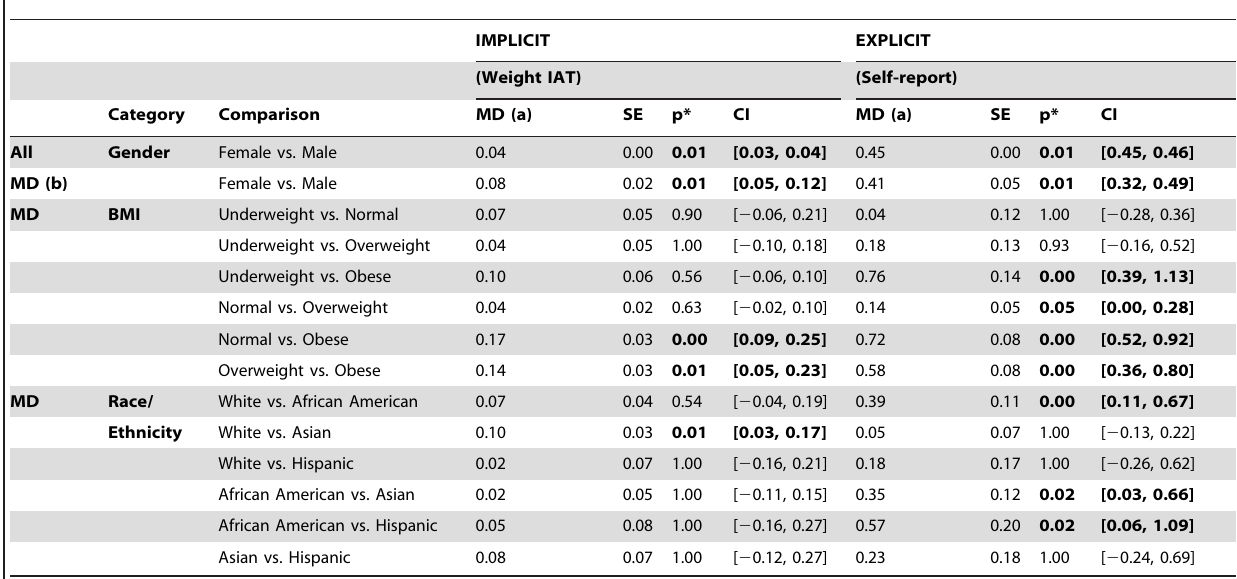
Table 3. Pairwise Comparisons of Implicit and Explicit Weight Attitudes for All Test Takers and MDs (medical doctors) as a function of Gender, and for MDs as a function of BMI and Race/Ethnicity